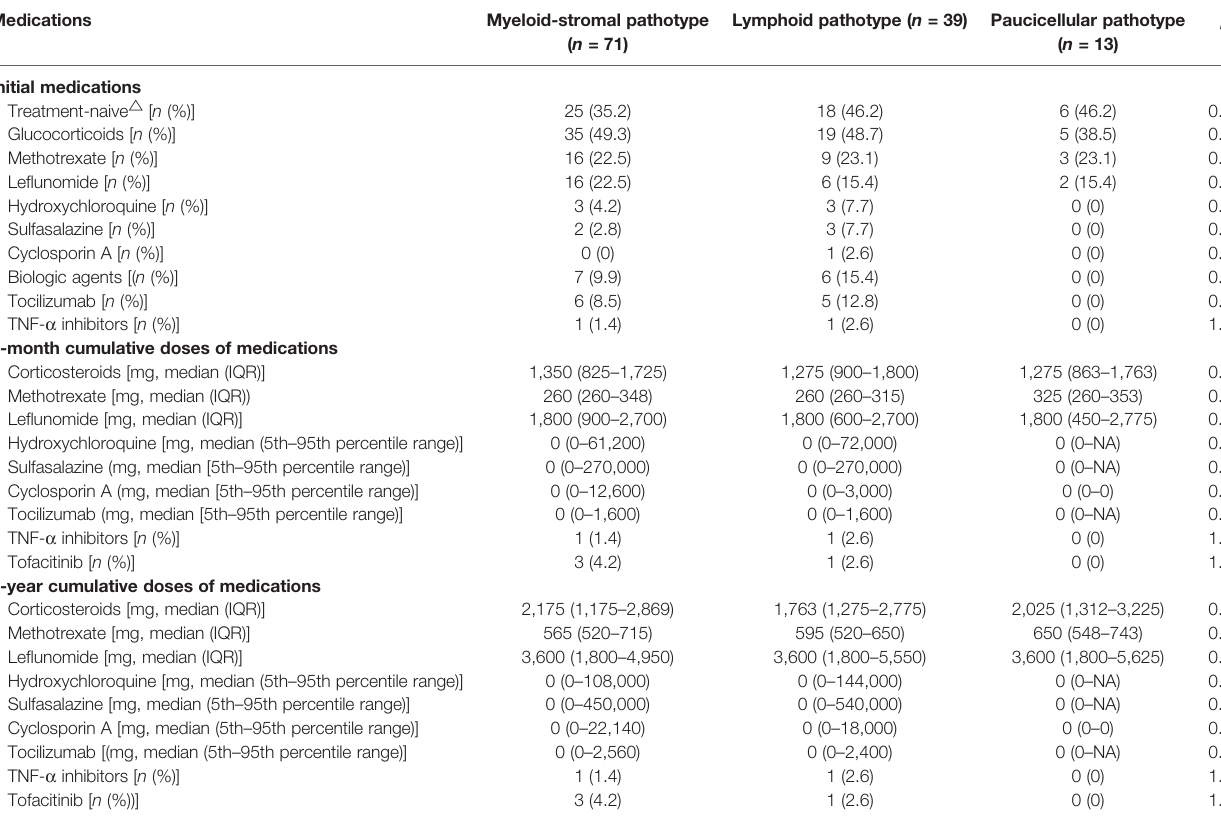
TABLE 3 | Medications in RA patients with three new synovial pathotypes.